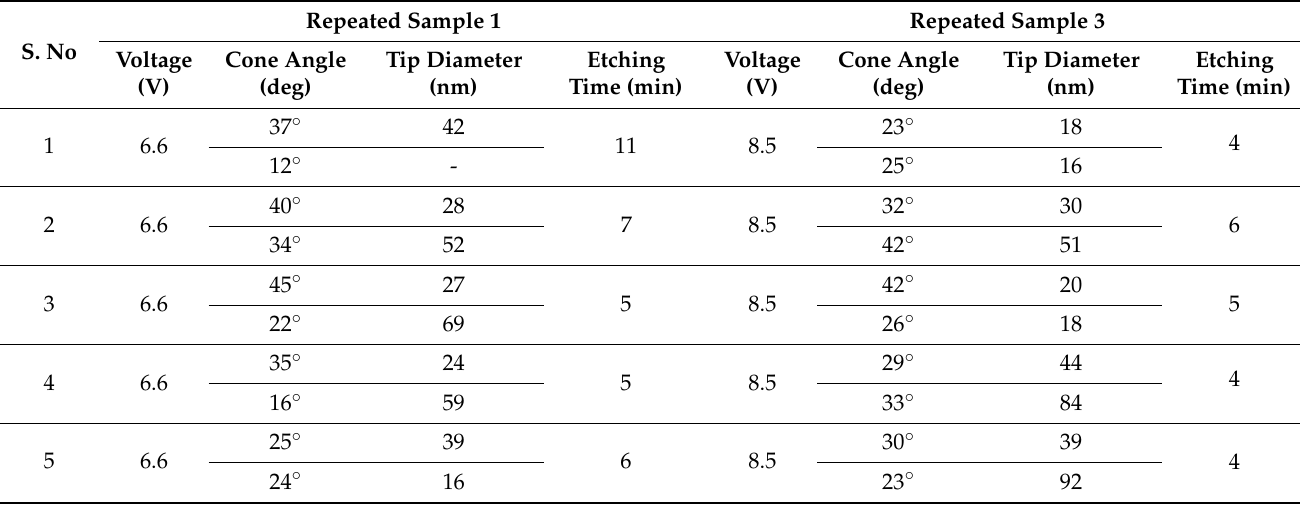
Table 4. Experimental results for 0.4 mm tips showing optimal results of Sample 1a and 3b in 2 M NaOH solution on Meniscus Etching.